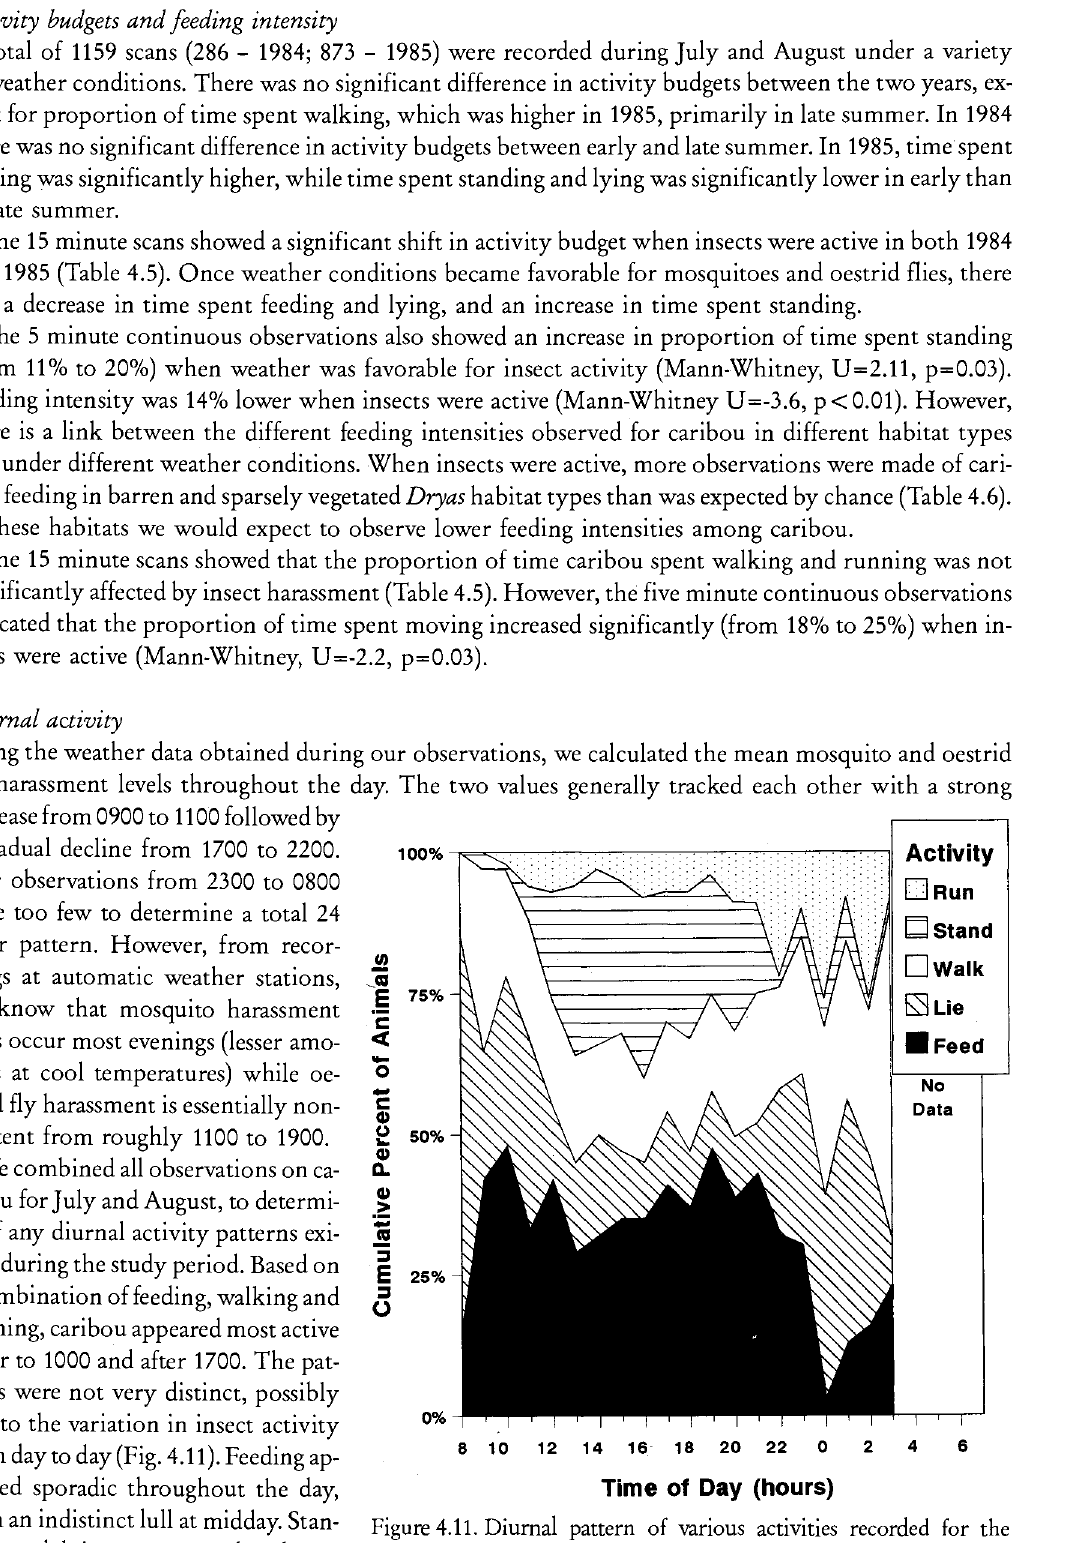
Figure 4.11. Diurnal pattern of various activities recorded for the Porcupine Caribou Herd in summer of 1984 and